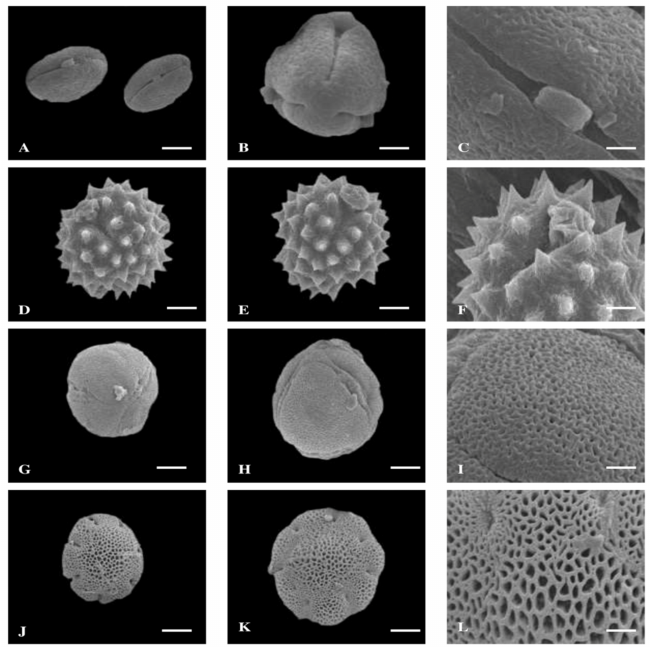
Figure 5. SEM images of pollen grains (Equatorial and Polar axis) and pollen surface ornamentation ( A – C ). The scale bar represents 5 µ m for Atriplex stoeksii ( D – F ), 5 µ m for Boerhivia procumbense ( G – I ), 10 µ m for Brassica furatii ( J – L ), and 10 µ m for Capparis decidua .